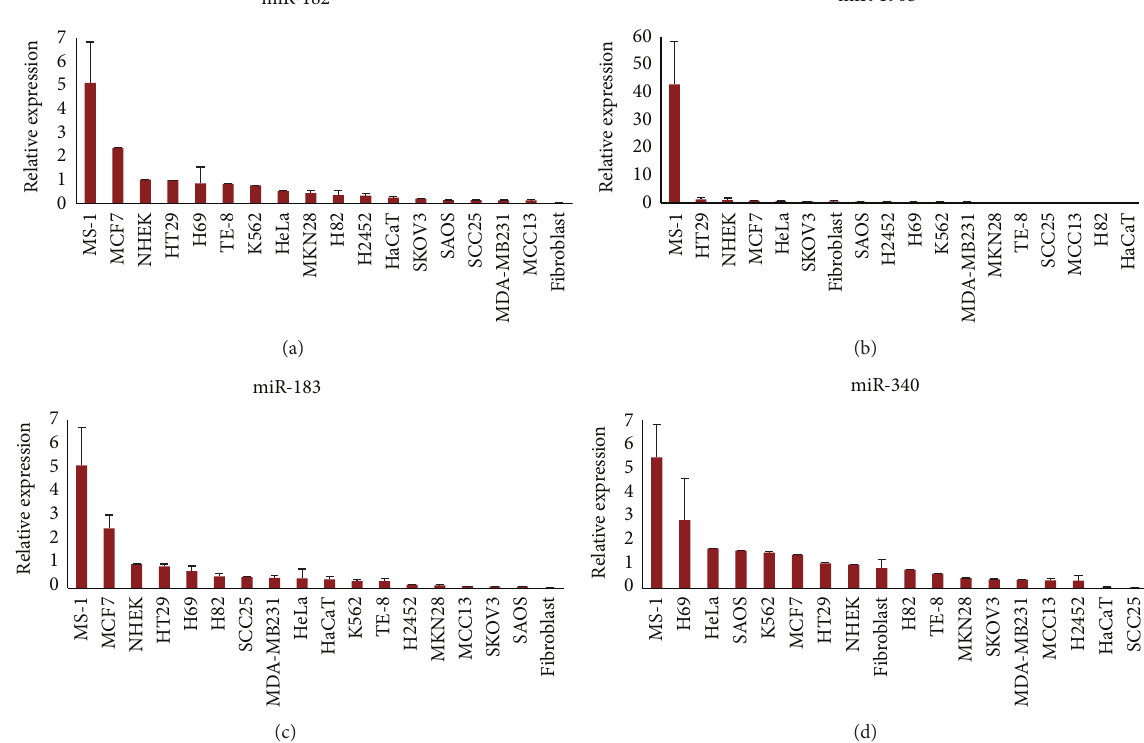
Figure 3: MCC-miRs are highly expressed in MS-1. Four MCC-miRs were confirmed via qRT-PCR to be upregulated in the MCC cell line, MS-1, versus sixteen other non-MCC cell lines: miR-182, miR-183, miR-190b, and miR-340. Error bars refer to